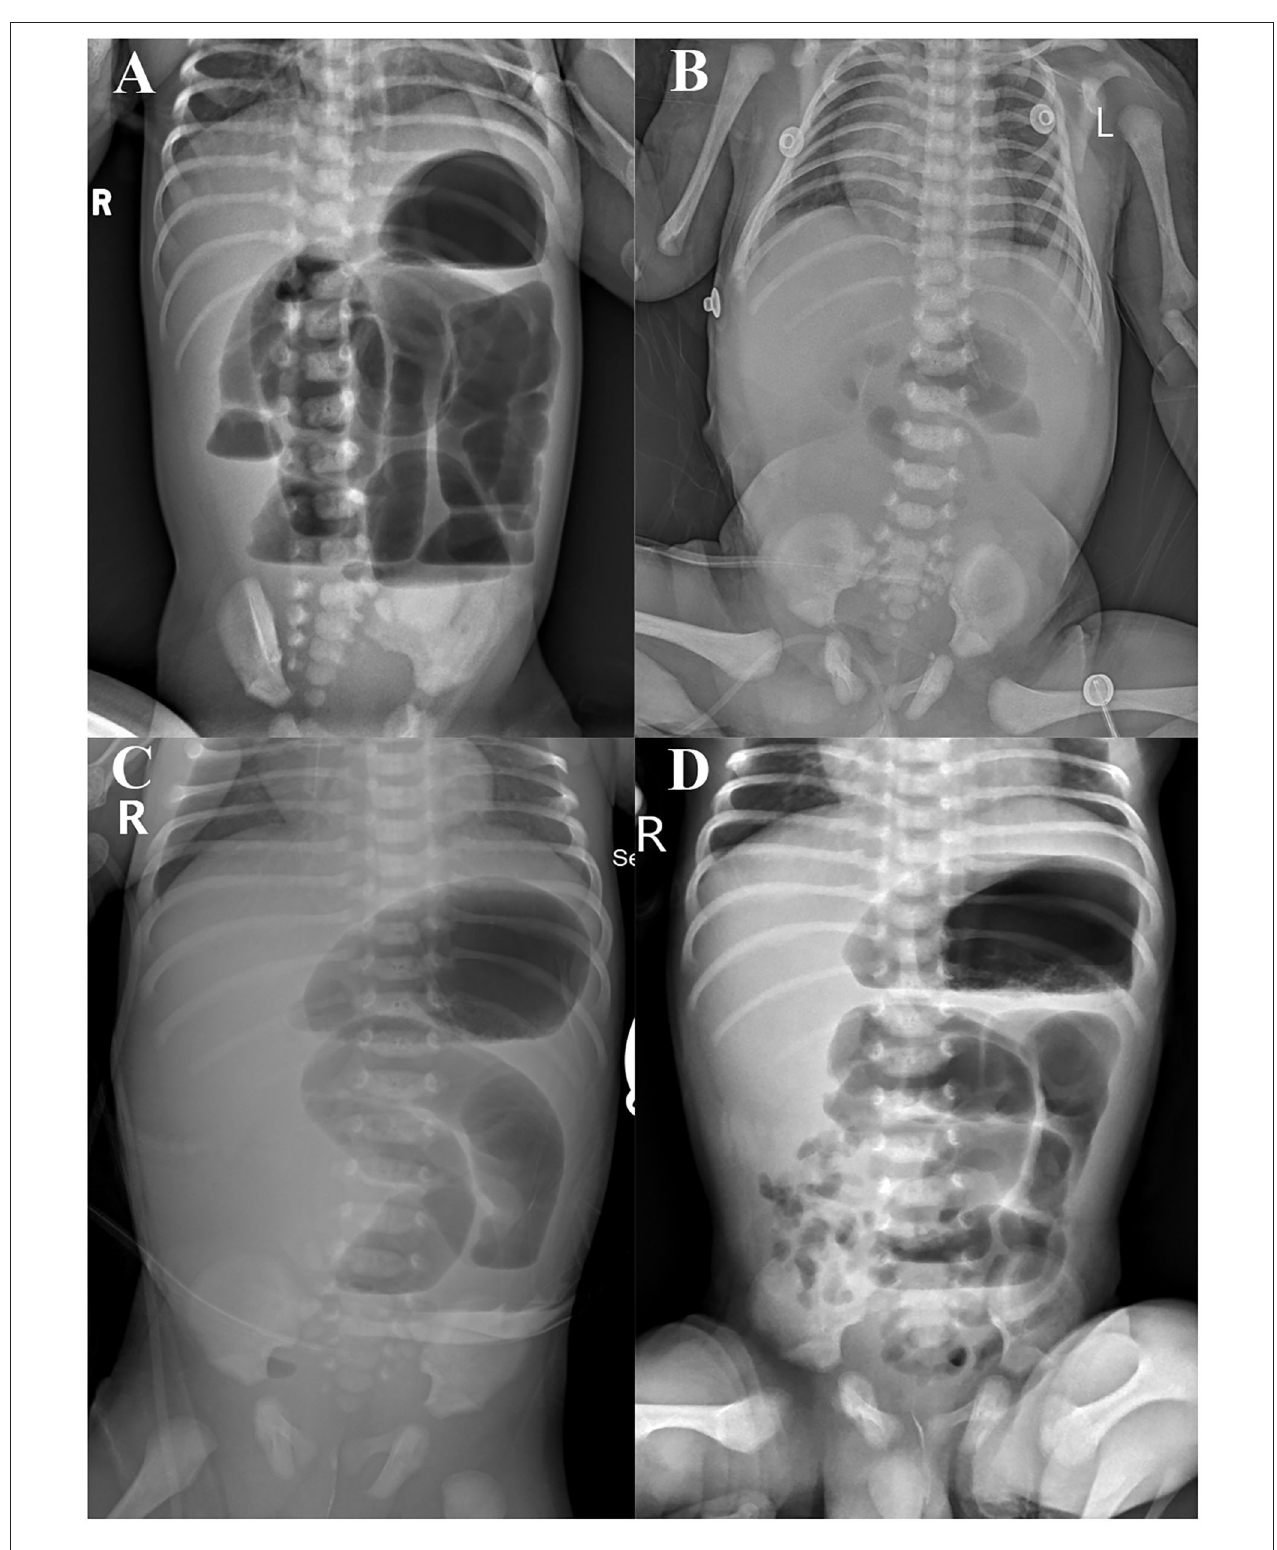
FIGURE 1 | Abdominal x-rays before (A) and after (B–D) the first surgery.